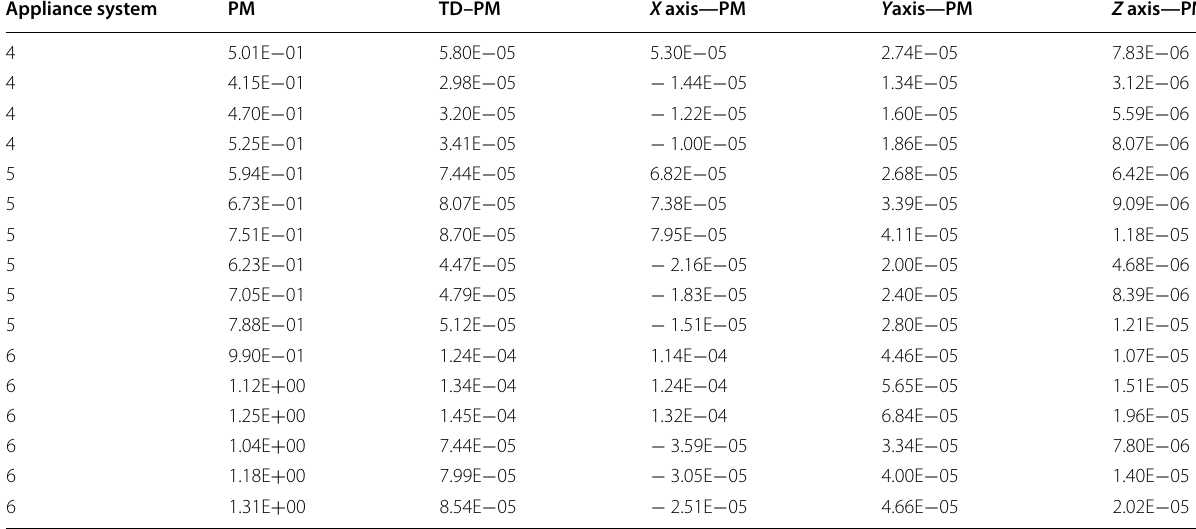
*Average values of the right side and left side of each suture and the surface landmarks are